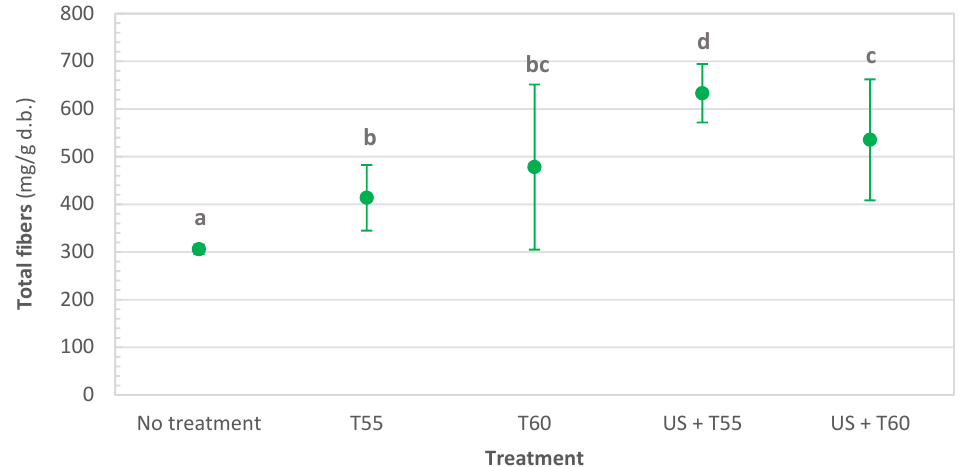
Figure 2. Total dietary fibers in untreated, thermally treated and thermosonicated kiwi peel. Values with different letters differ significantly ( p < 0.01 ).